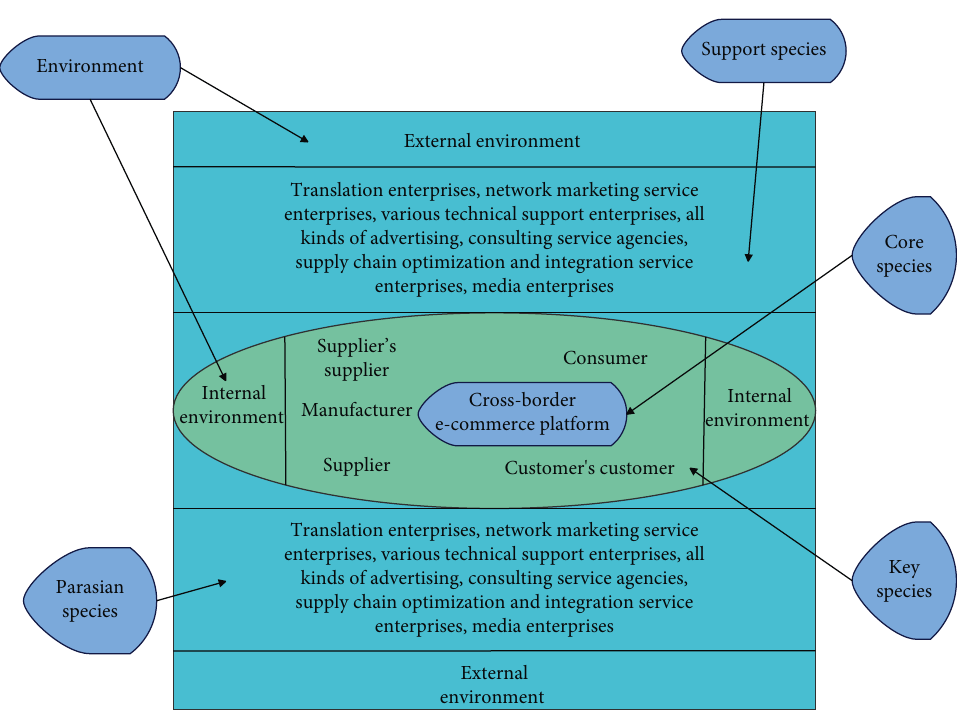
Figure 13: Cross-border e-commerce logistics collaboration